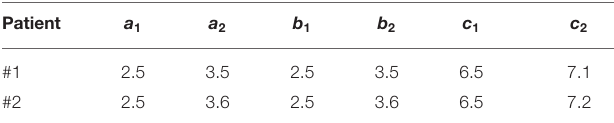
TABLE 3 | Parameters of the truncated ellipsoidal geometries expressed in cm